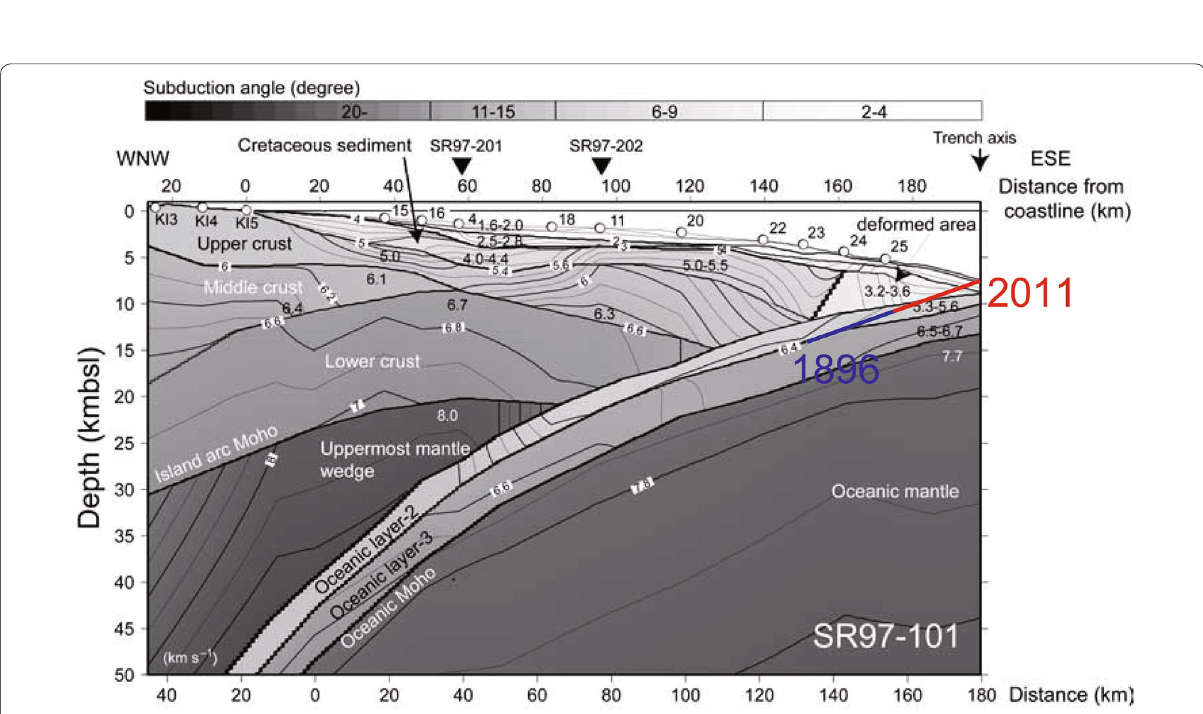
Fig. 6 Velocity structure profile touched in Takahashi et al. (2004). Both 1896 and 2011 slips were on the shallowest part of the subduction zone near trench axis, below low velocity